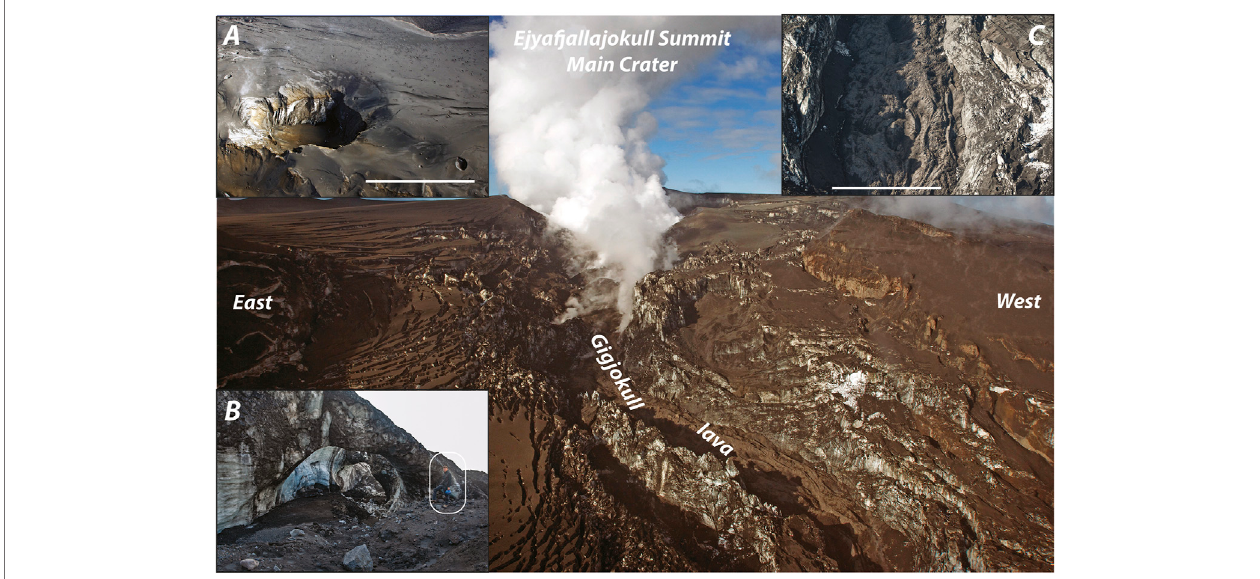
FIGURE 5 | Effects of ice on the 2010 Eyjafjallajökull eruption, south-central Iceland. Main view is from the north looking at the tephra-covered ice of Gigjökull and thesummitofEyjafjallajökull,withthecanyonformedbymeltwaterandlavainthemiddleoftheimage. (A) Anexplosioncraterinthesummiticepartly fi lledwithtephra. (B) Anice ‘ arch ’ remnantofanN-channelatthebaseofGigjökullthroughwhichlavamigratedbeneaththeice. (C) Thelaststageoflavaeffusionwasasubaerial,blockylava emplaced into an ice canyon that con fi ned the lava.